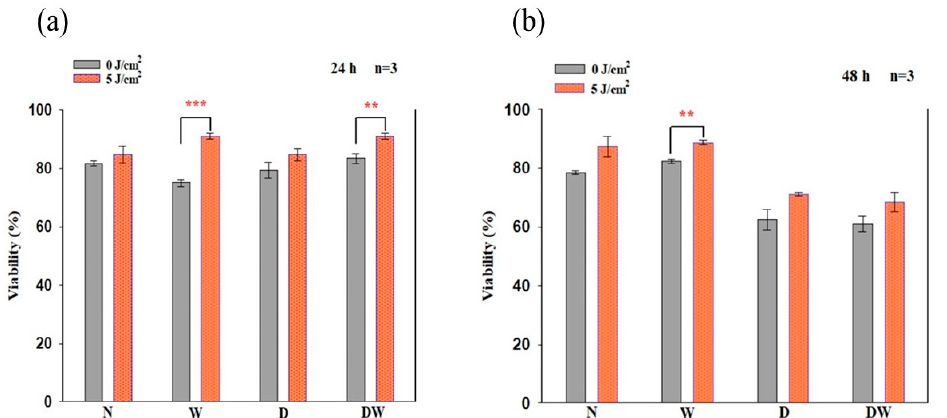
Figure 3. Viability of cells in percentage (%) as determined by the Trypan blue exclusion assay in non-irradiated and irradiated normal (N), wounded (W), diabetic (D), and diabetic wounded (DW) cells observed at 24 h ( a ) and 48 h ( b ) following irradiation at a wavelength of 660 nm with a fluence of 5 J/cm 2 . Data are expressed as ± SEM (n = 3). Significant probabilities compared to the non-irradiated controls are shown as ** p < 0.01 and *** p <